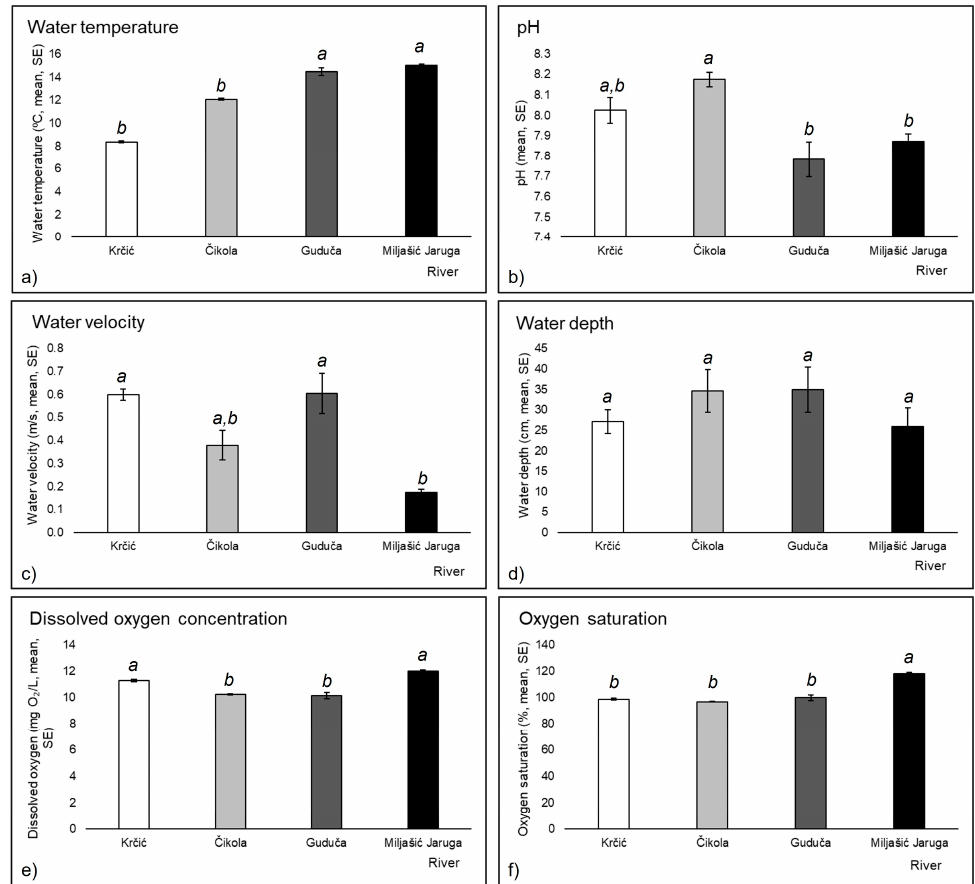
Figure 2. Physico-chemical parameters of the water measured at four intermittent rivers in the karst Mediterranean region of the Balkans shown as mean with standard error (SE): ( a ) water temperature, ( b ) pH, ( c ) water velocity, ( d ) water depth, ( e ) dissolved oxygen concentration, ( f ) oxygen saturation.